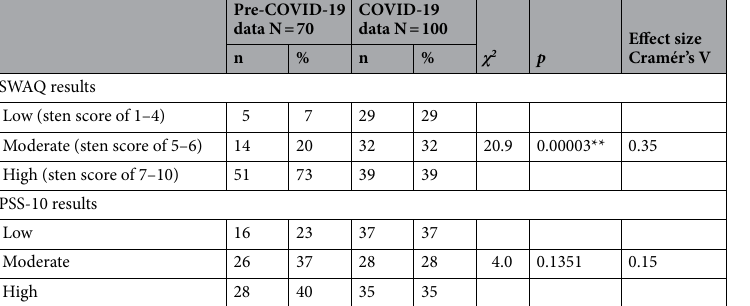
Table 4. Comparison of the PSS-10 and SWAQ results—a qualitative analysis ( χ 2 test) . SWAQ the Subjective Work Assessment Questionnaire, PSS-10 the Perceived Stress Scale. **Statistically significant values p <